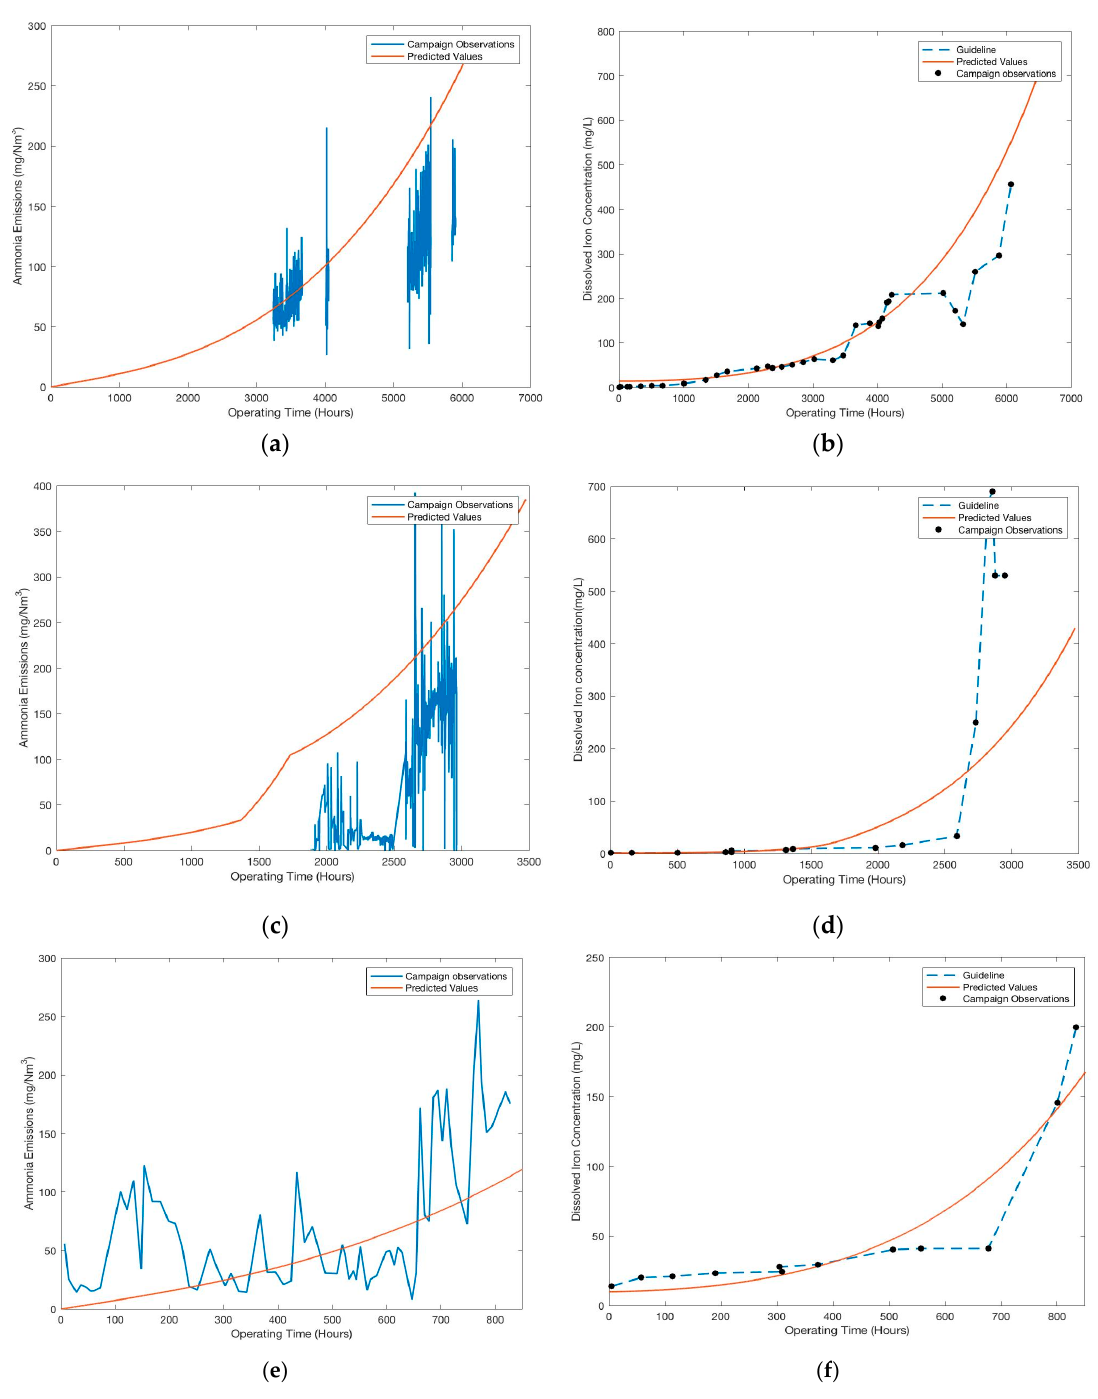
Figure 6. Validation of auto-catalytic model by comparing; ( a ) Ammonia emissions at Esbjerg power plant; ( b ) Dissolved metal concentration for Esbjerg Pilot campaign; ( c ) Ammonia emissions for TNO’s campaign; ( d ) Dissolved metal concentration emissions for TNO’s campaign; ( e ) Ammonia emissions for PCCC campaign at Loy Yang power plant.; and ( f ) Metal concentration for PCCC campaign at Loy Yang power plant.